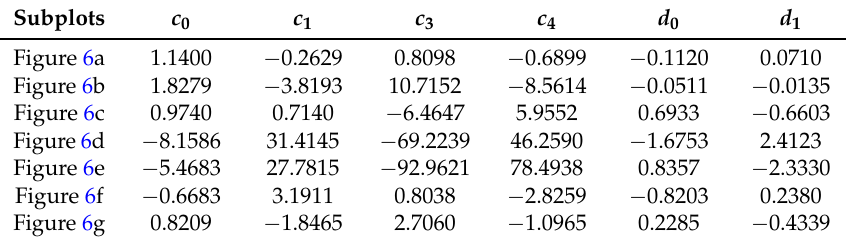
Table 6. Parametric equation coefficients of the solid lines in Figure 6.